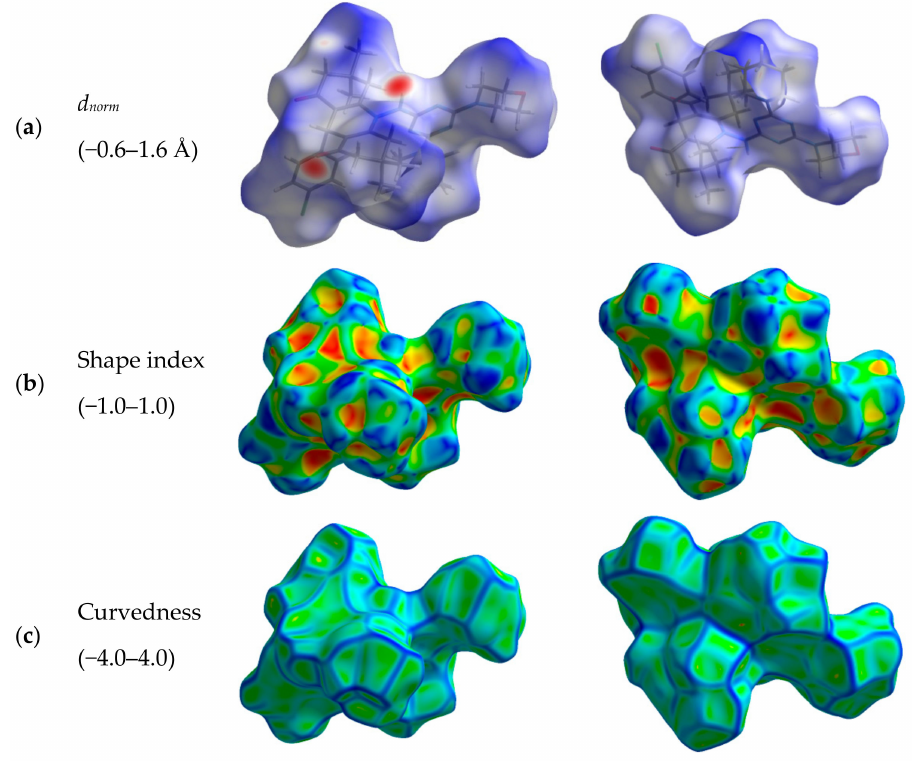
Figure 3. Hirshfeld ( a ) d norm , ( b ) shape index, and ( c ) curvedness maps for compound 4